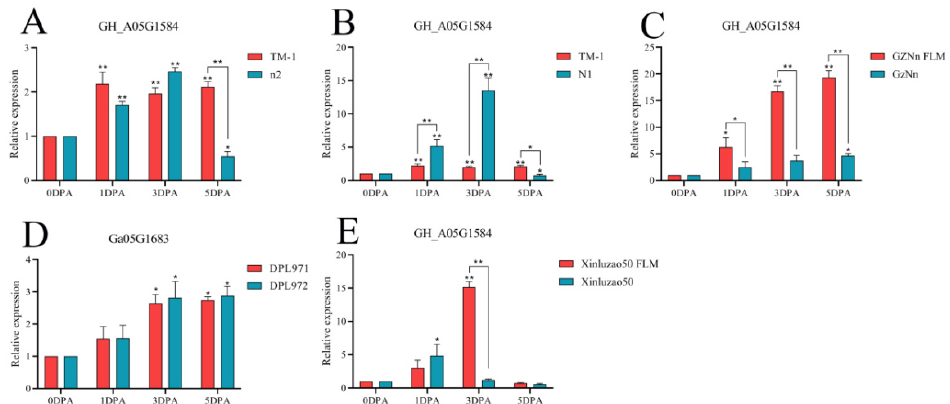
Figure 16. Relative expression levels of the GH_A05G1584 gene in upland cotton. ( A – C , E ) Upland cotton; ( D ) homologous gene of Asian cotton. Asterisks at top of bars indicate statistically significant differences between periods (* p < 0.05, ** p < 0.01).